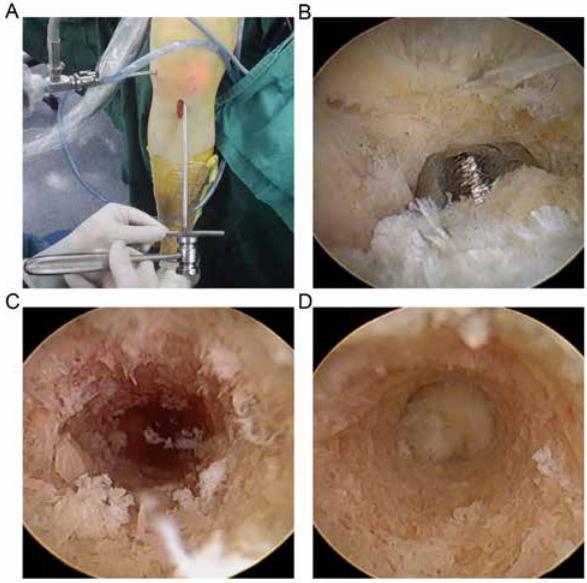
Figure 1: Dilation process. (A): Dilating the tibial tunnel; (B): The dilator passed through the tibial tunnel;(C): The inner tunnel wall was porose and littery before dilation; (D): After a series of expansion, the texture of the tunnel wall was close-grained and consolidated.